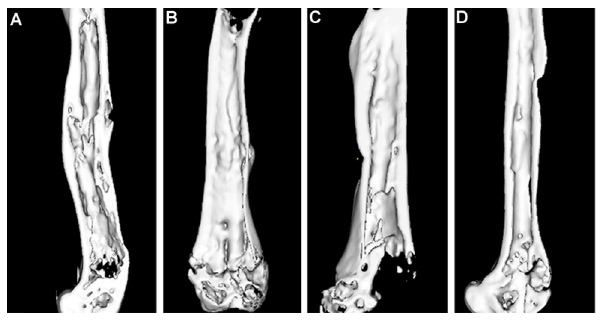
Figure 5. Representative micro-CT slices after 5 and 10 weeks of fracture healing in a control and a telmisartan-treated animal. A, C for the vehicle-treated group and B, D for the telmisartan- treated